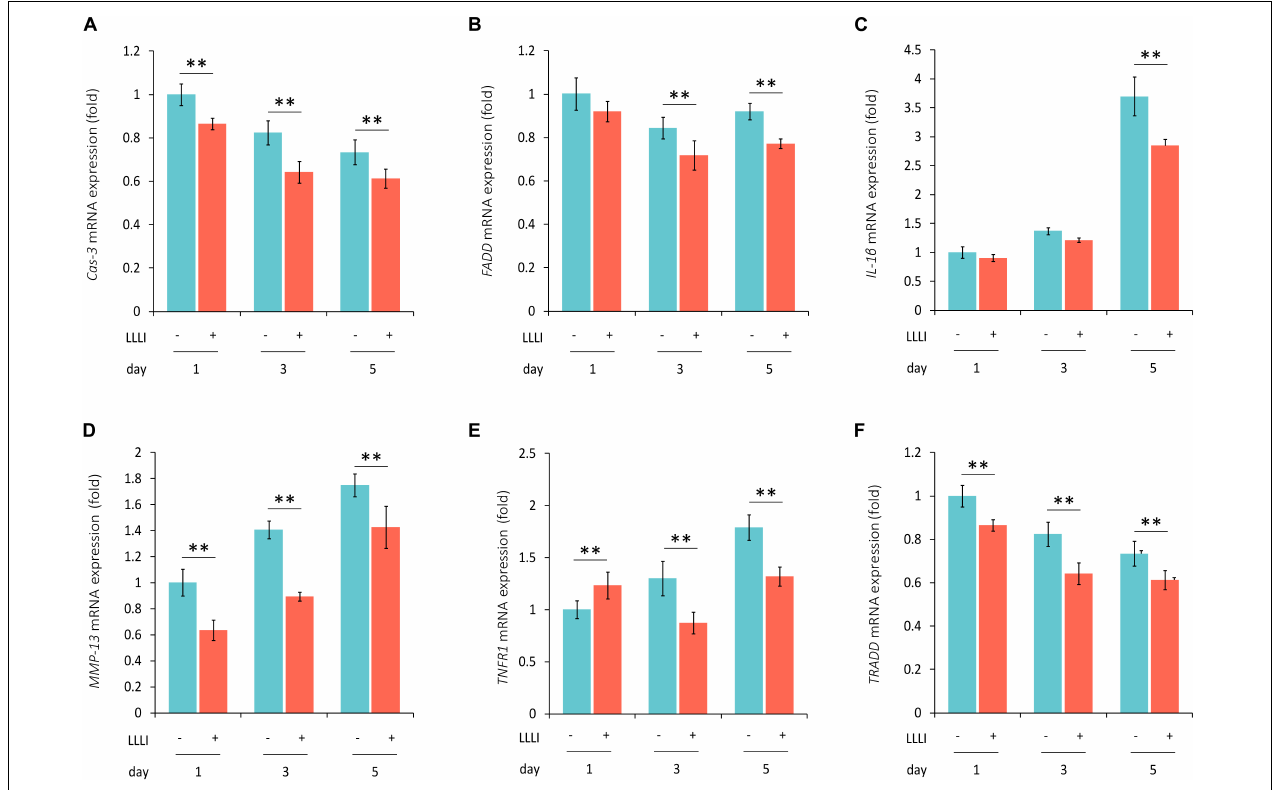
FIGURE 6 | qRT-PCR analysis of the expression of genes associated with cell death and matrix destruction in human C28/I2 chondrocytes. The cells were treated with LLLI of 5.74 J/cm 2 daily in culture for 1, 3, and 5 days, respectively, followed by further culture for 24 h before harvested for isolation of total RNA ( n = 3). The expression of 4 genes were significantly ( ∗∗ ) downregulated by all dosages of LLLI compared to the respective control, i.e., Cas-3 (A) , MMP-13 (D) , TNFR1 except for an upregulation by 1 X IU (E) , and TRADD (F) . FADD expression seemed to be downregulated by all 3 dosages of LLLI, but was not statistically significant for LLLI of 5.74 J/cm 2 daily in culture for 1 day (B) . The expression of IL-1 β was relatively stable in LLLI of 5.74 J/cm 2 daily in culture for 1 and 3 days compared to controls. Expression was increased in untreated and treated cells by 5 days with expression significantly ( ∗∗ ) downregulated by LLLI of 5.74 J/cm 2 daily in culture for 5 days (C) . GAPDH was used as an internal reference. The figure was plotted using data from triplicate samples, each with triplicate measurements. Daily LLLI treatment = 5.74 J/cm 2 of LLLI for 8 min; Error bar = SD; ∗∗ P <